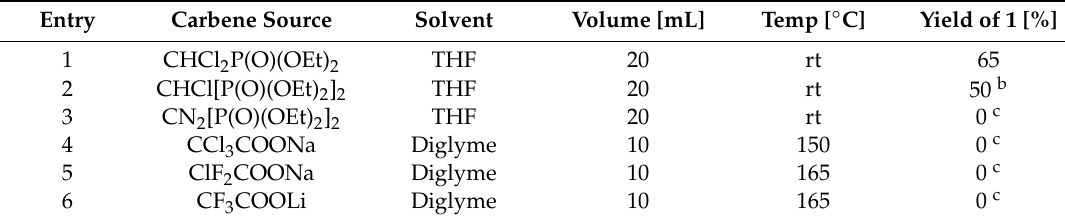
Table 1. Carbene insertion into 11 a .